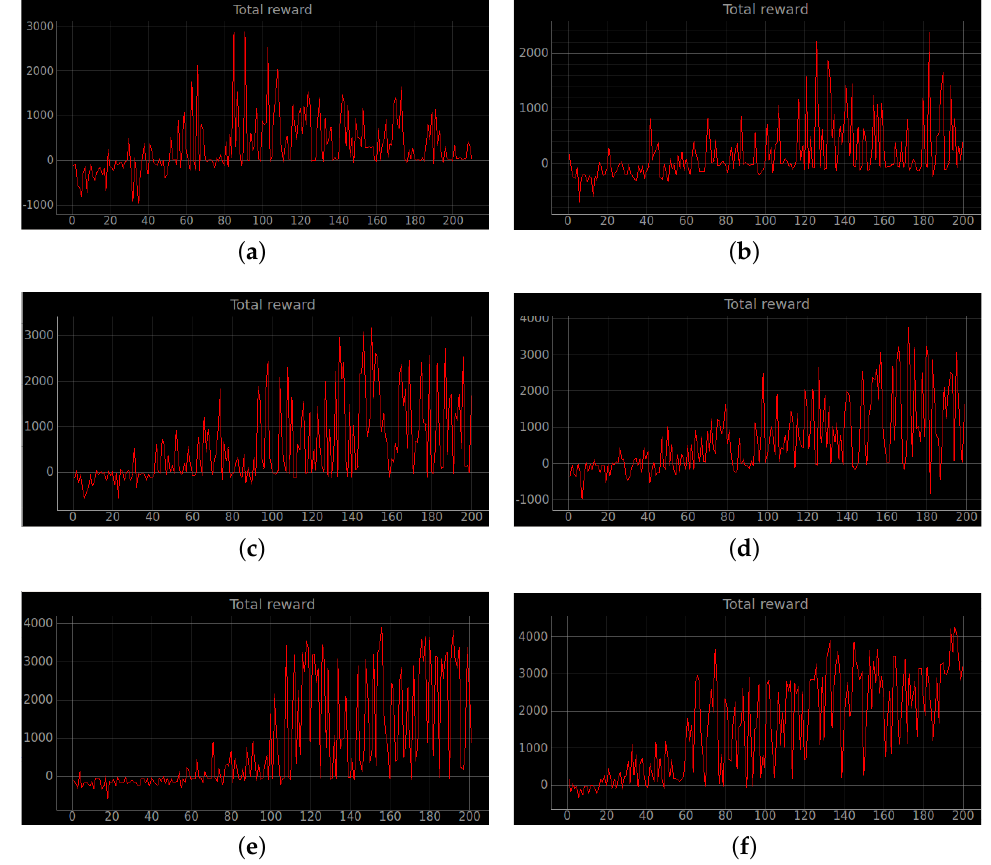
Figure 8. Robot path planning simulation results. The image above shows the total rewards ob- tained by the robot in six algorithms under stage 2, which contains an unknown environment of static obstacles. ( a ) Original DQN; ( b ) Double DQN; ( c ) Dueling DQN; ( d ) D3QN; ( e ) ND3QN; ( f )